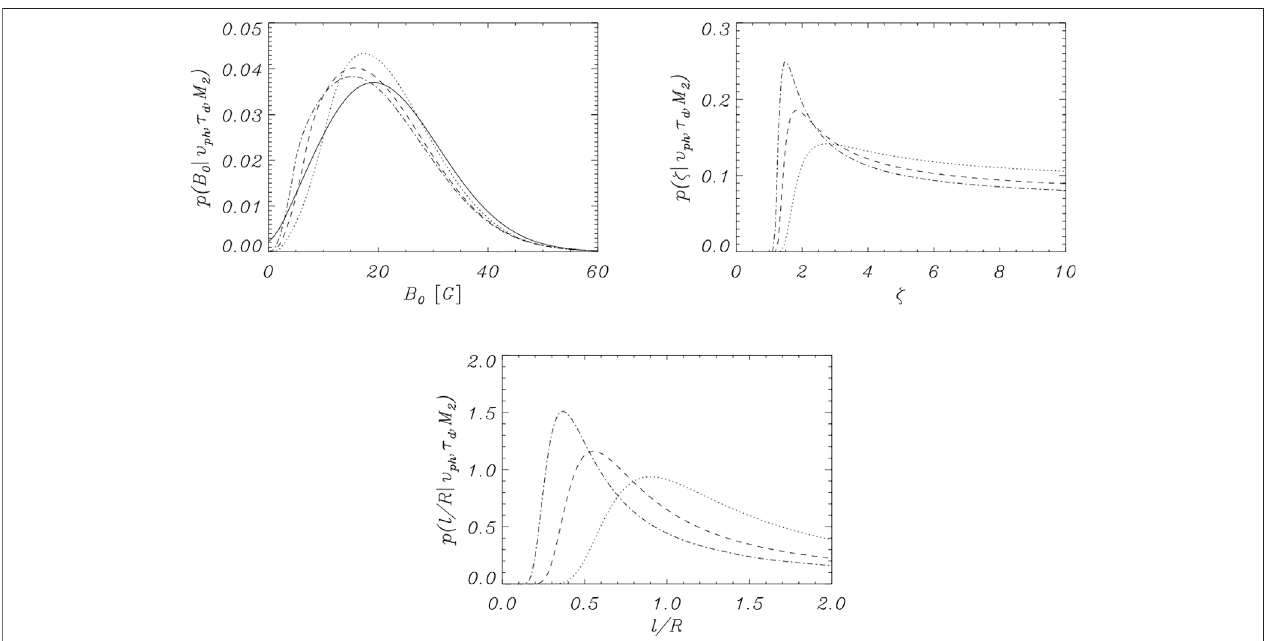
FIGURE3| Marginalposteriordistributionsformagnetic fi eldstrength,densitycontrast,andtransverseinhomogeneitylengthscalefortheinversionoftheproblem withforwardmodelgivenby Eqs6 , 7 ,atransverseoscillationwith v ph =1,030±410 km s − 1 anddifferentvaluesforthedampingtime:nodamping(solidline), τ d =500 s (dotted line), τ d = 800 s (dashed line), and τ d = 1,200 s (dash-dotted line) with an associated uncertainty of 50 s in all cases. The inferred medians with errors at the 68% credibleintervalare